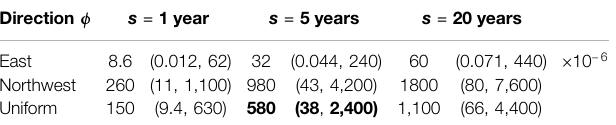
TABLE 1 | Numbers in the table (note division by one million on the left) are mean probabilitiesofinundatingPlymouthwithin s yearsfor fl owswithinitialdirection ϕ (cid:2) 0 + (dueeast), ϕ (cid:2) 135 + (northwest),or ϕ drawnuniformlyfrom (− 180 + , 180 + ) , along with 95% posterior credible intervals. Middle column of bottom row (in bold) corresponds to the histogram shown in Figure 10D below, with mean 5 . 8 · 10 − 4 and 95% credible interval ( 3 . 8 · 10 − 5 , 2 . 4 · 10 − 2 ) . Note intervals are asymmetric due to skewness of the distribution. Probabilities increase with intervalduration s andarehighestfor fl owsdirectedNWtowardPlymouthand lowest for fl ows directed due east down the Tar River Valley toward the